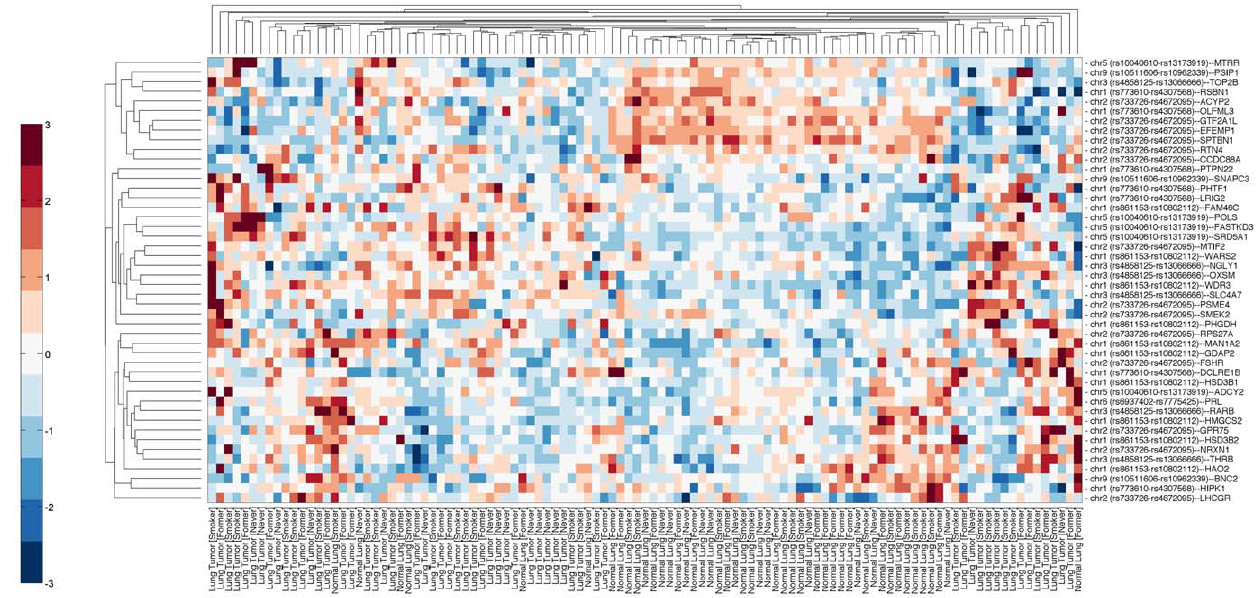
Figure 4. Clustering of gene expression profiles for genes residing within significant c/aTOH + / 2 250 kb regions. Bi-clustering of relative gene expression (horizontal) classified by ‘‘LC (tumor) + smoking status’’ and ‘‘normals + smoking status’’ (vertical). The acquisition, re- standardization and merging of expression array data with TOH regions are detailed in the Methods section. Red coloration on the heat map is relative over-expression of the genes, blue denotes relative under-expression and white no distinct relative expressional difference observed. The heat map represents the differential expression profiles of 47 genes that were selected after univariate analysis (see Methods section for details). The expression profiles of genes residing within and in proximity to the c/aTOH regions that are associated with tobacco use differentiate lung carcinomas from normal lung tissue.